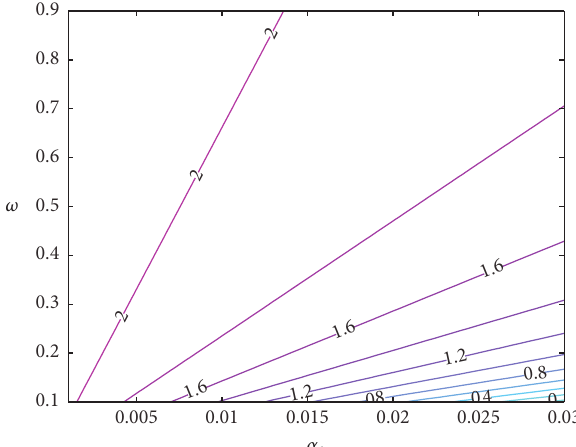
= (0.199, 0.0313) , 𝛿 = (0.0001, 0.0013) , 𝜔 = 0.2 , 𝛼 1 2 = (8 × 10 −7 , 8 × 10 −8 ) , 𝛼 = (9.99 × 10 −7 ,9.9 × 10 −8 ) , 𝜂 = 1.5 , and 𝜌 = 0.497 . 4 5